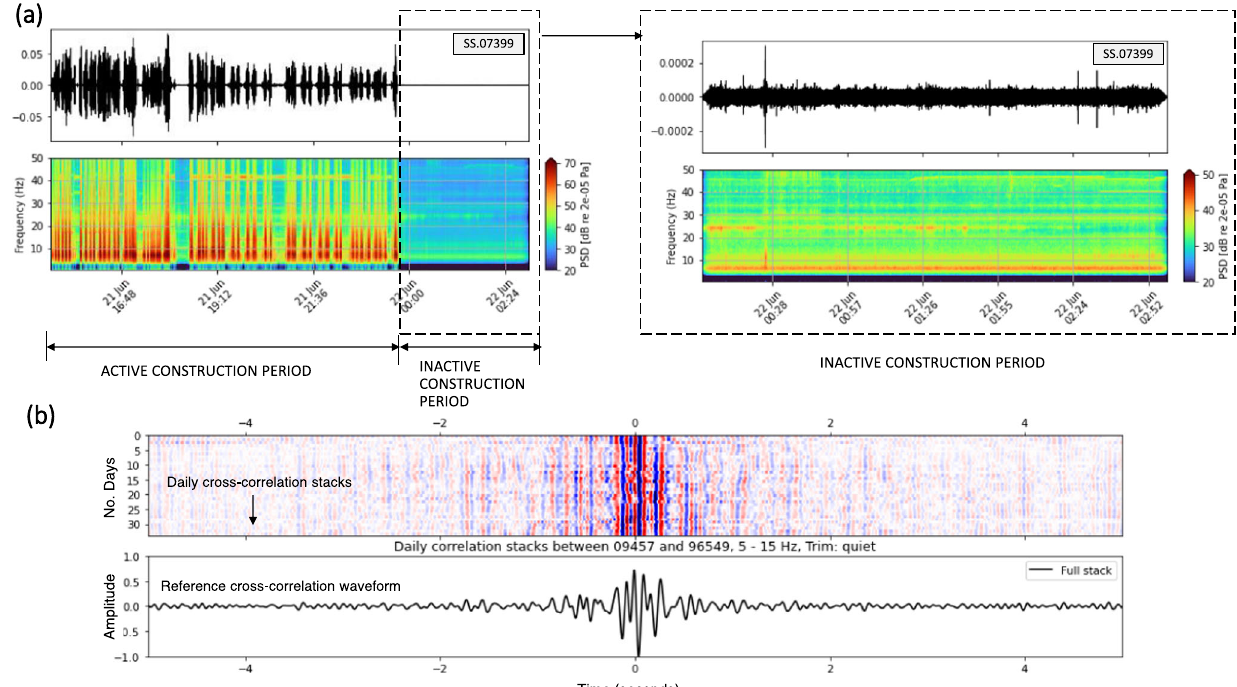
Fig. 2 Overview of raw seismic data, spectral frequency and cross-correlations. a Spectral frequency content for a single station on one day of data acquisition for active and inactive construction periods. b Daily cross-correlations over data acquisition period for a single station pair. The lower graph shows the stacked (reference cross-correlation) waveform of individual daily cross-correlations over the data acquisition period.